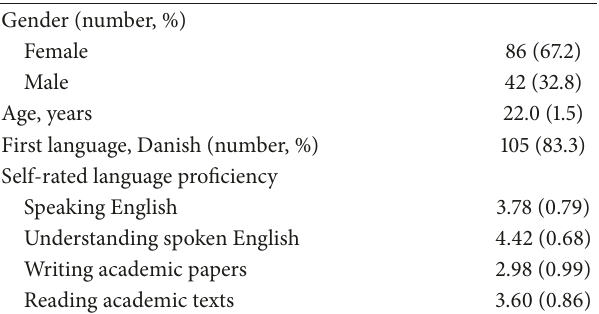
Table 3: Biographical data and language